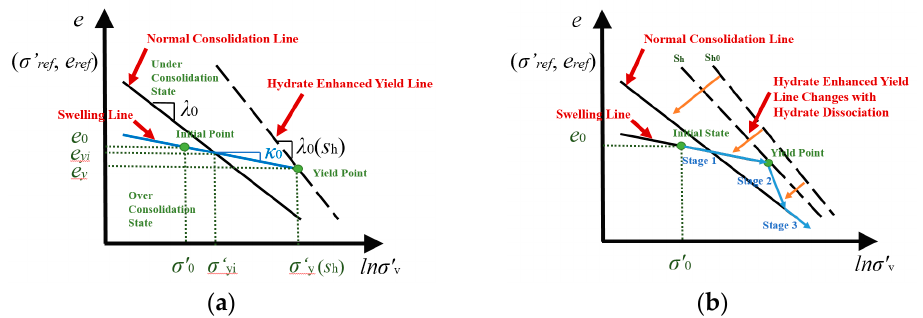
Figure 2. The sediment generally experiences three stages during depressurization and hydrate dissociation including ( a ) the hydrate effects on compression behavior and ( b ) stress state change during depressurization.